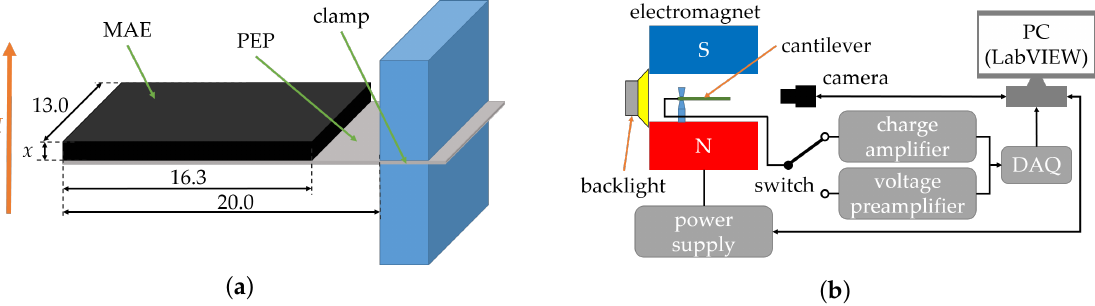
Figure 1. Sketch of a clamped cantilever [24] ( a ) and schematic of the experimental setup ( b ). Dimensions are given in